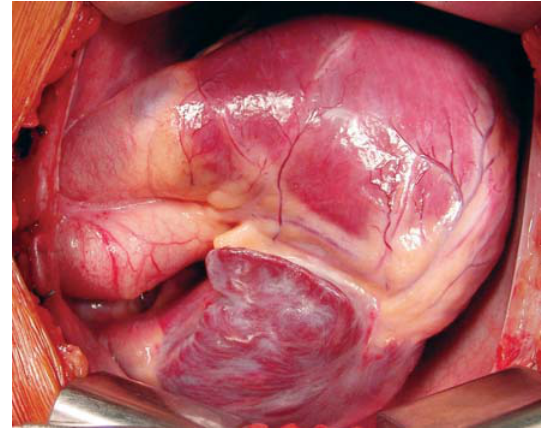
Fig. 3 – Distensão das câmaras direitas após abertura do pericárdio